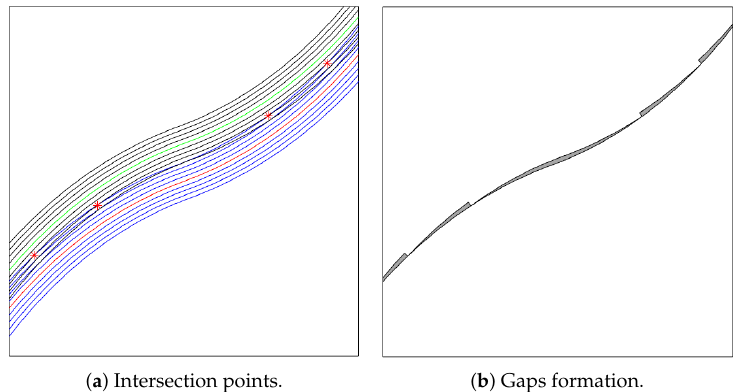
Figure 3. Intersection between the shifted course and the reference course. The distance between two sets of gaps is the shift distance and, thus, the gap set is translated vertically to generate the defects across the entire ply. The gap distribution is then intersected with the skin mesh to calculate the gap area within an element. Figure 4 illustrates the intersection between the skin mesh and the gaps generated in the ply.